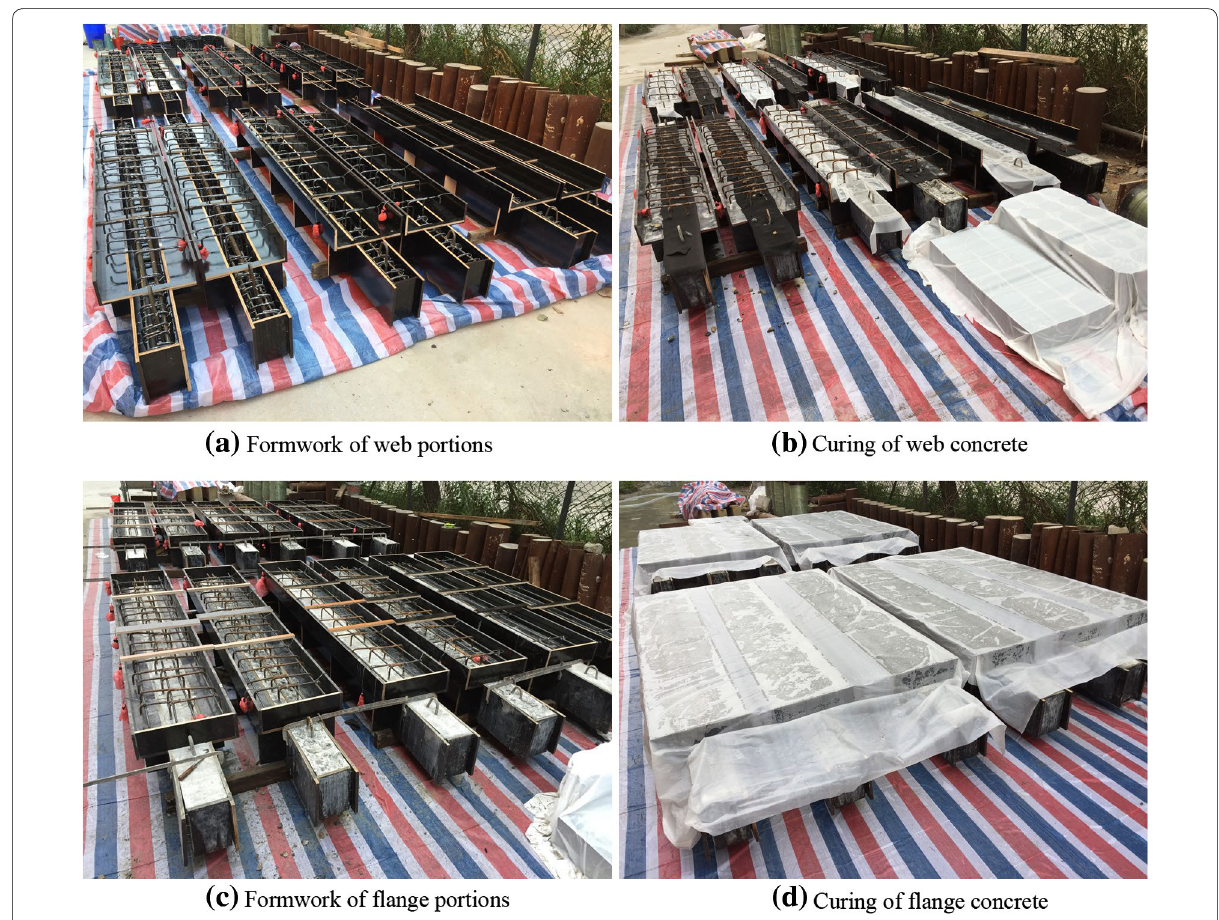
Fig. 2 Casting procedure of test